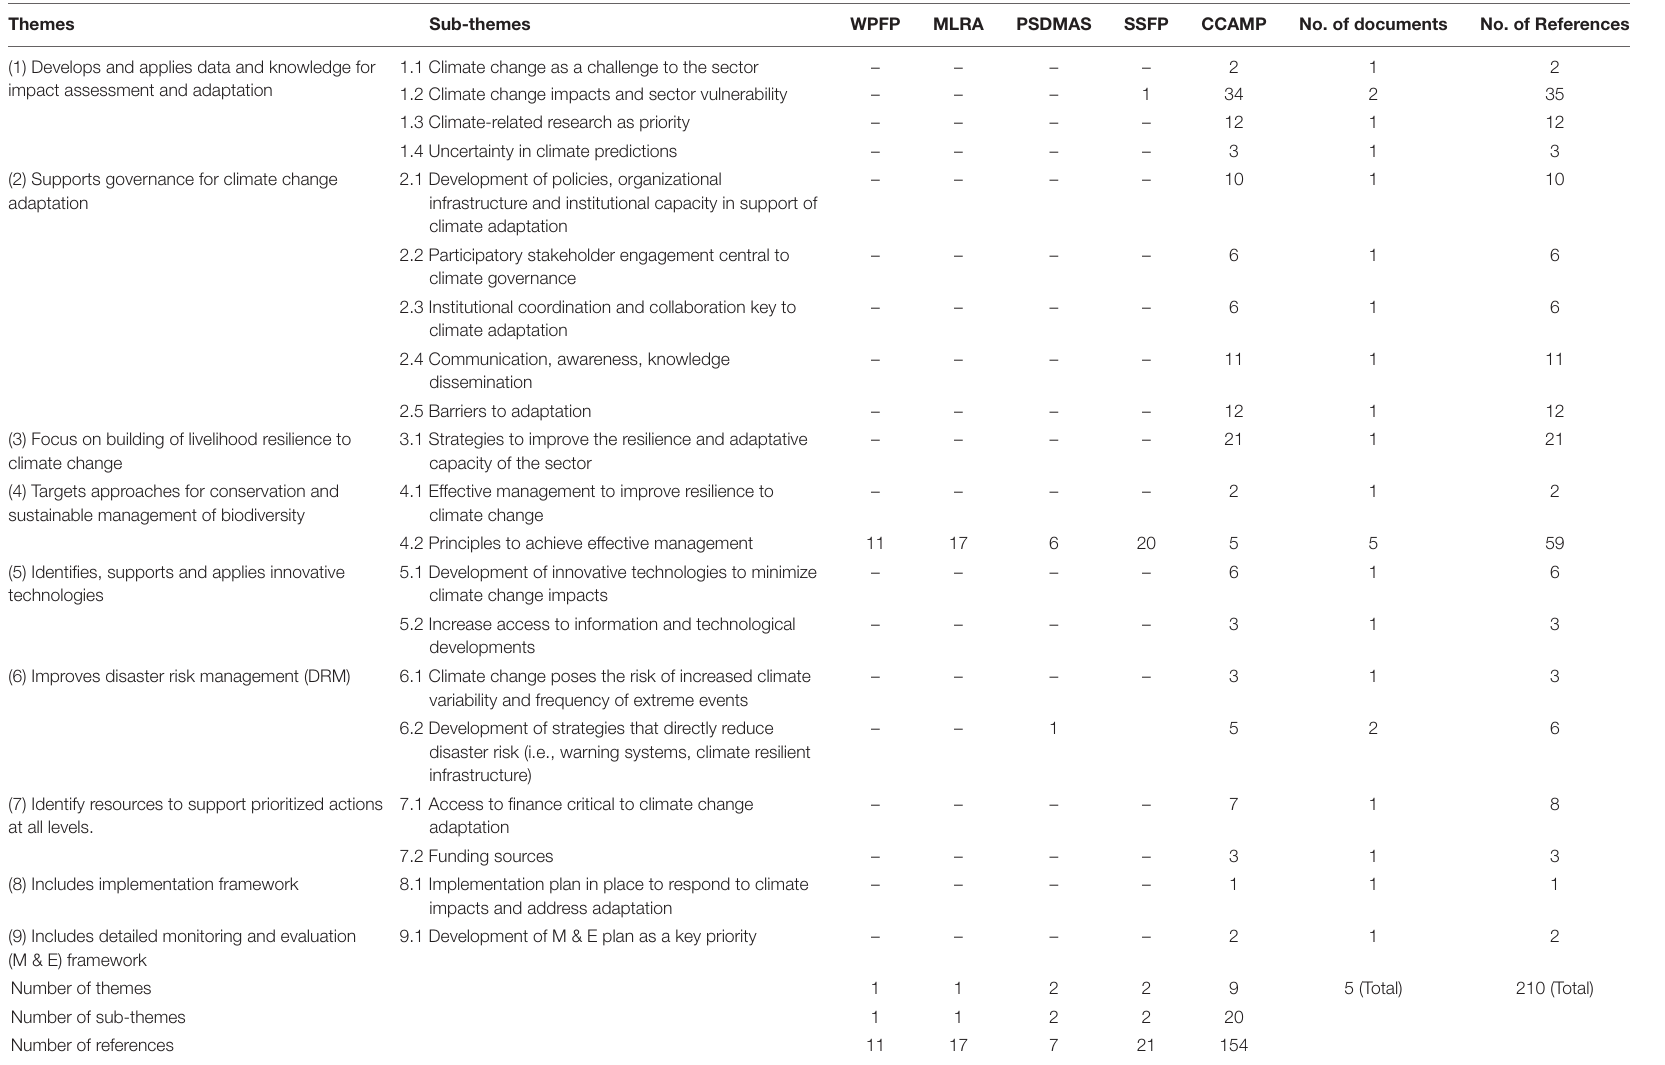
TABLE 5 | Number of direct climate references identified in the fisheries documents.